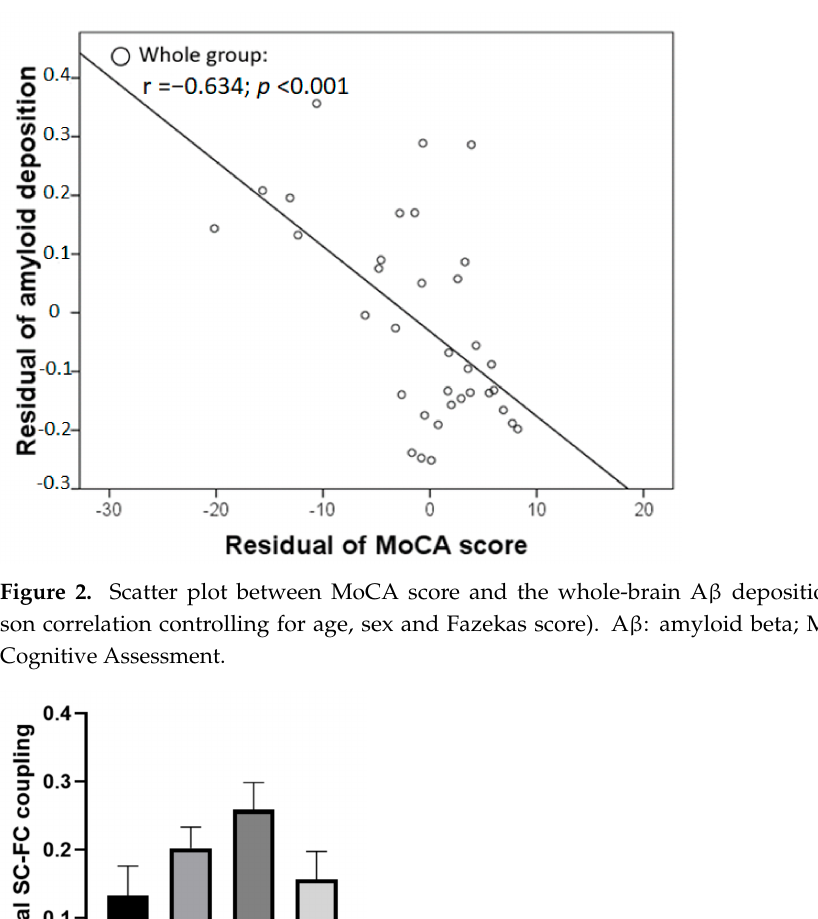
Figure 1. 18 F-flutemetamol PET-CT images of patients with ( A ) MCI_A β -, ( B ) MCI_A β +, and ( C ) AD. HC: healthy controls; A β : amyloid beta; MCI_A β -: mild cognitive impairment patient with negative A β ; MCI_A β +: mild cognitive impairment patient with positive A β ; AD: Alzheimer’s disease.